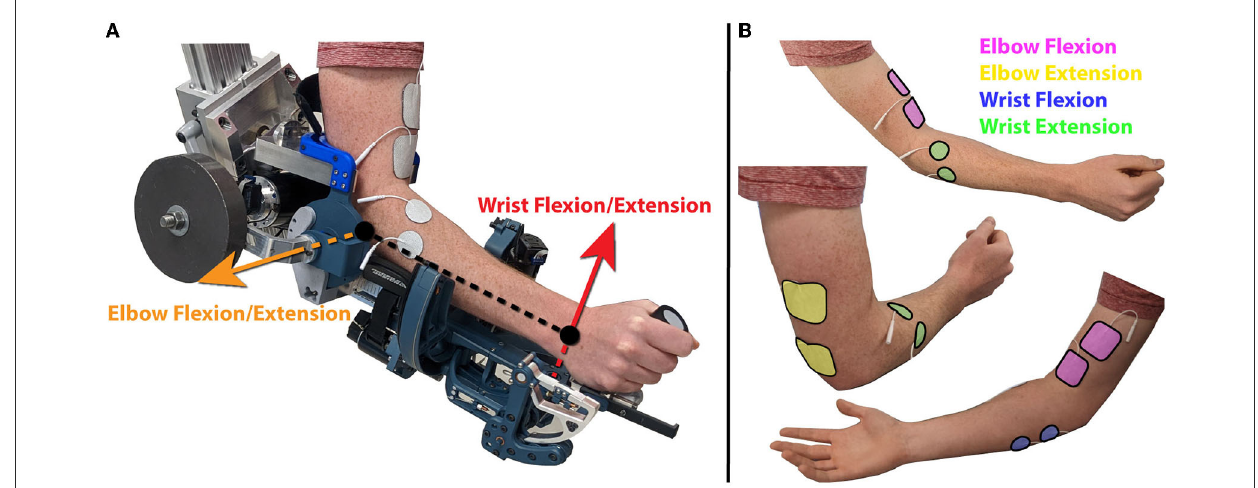
FIGURE2 (A) A participant with their arm in the robot in the experimental setup, with the axes of rotation for the active joints indicated by orange and red arrows for the elbow flexion/extension and wrist flexion/extension joints respectively. (B) Placement of each of the four sets of electrodes. Electrodes were placed over the biceps for elbow flexion over the triceps for elbow extension. Electrodes were placed on the flexor carpi ulnaris for wrist flexion, and extensor carpi radialis longis and extensor carpi ulnaris muscles for wrist extension.